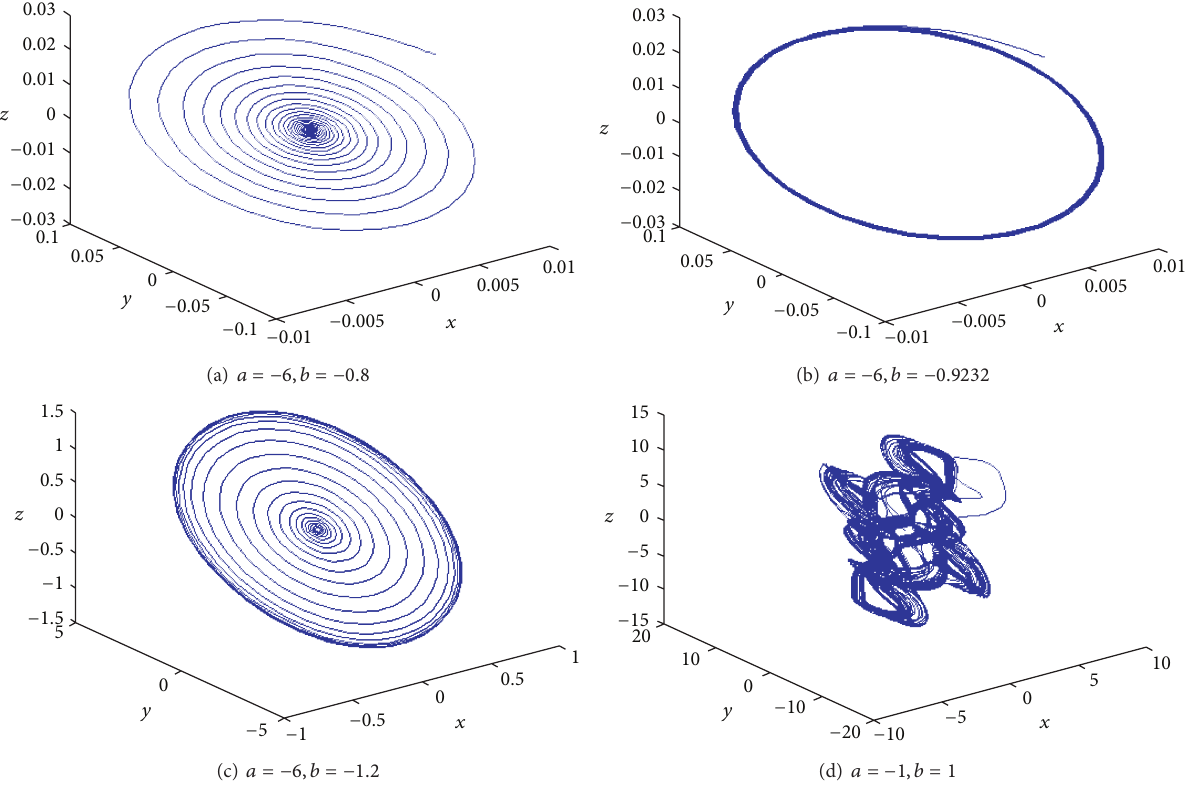
Figure 7: Phase diagram of system (3) with different